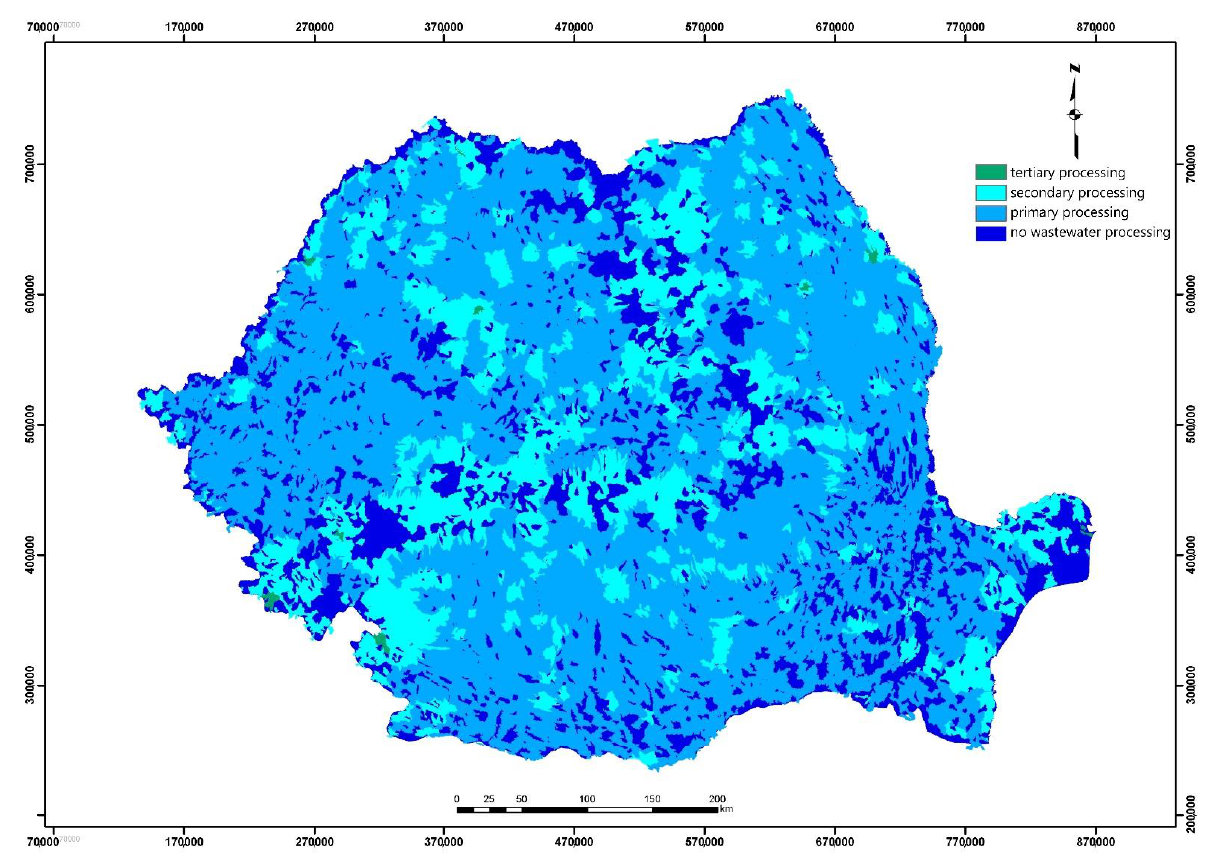
Figure 4. Initial processing of input data: wastewater processing.